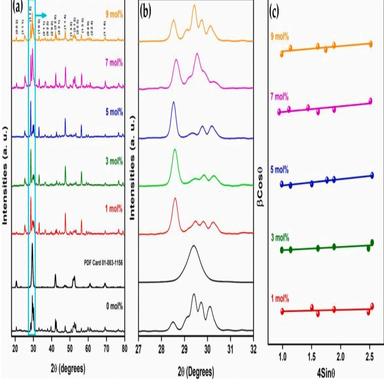
PXRD profiles (a), structural disorder (b), and W–H plot (c) of the prepared SCDx NPs (x = 1–9 mol%).